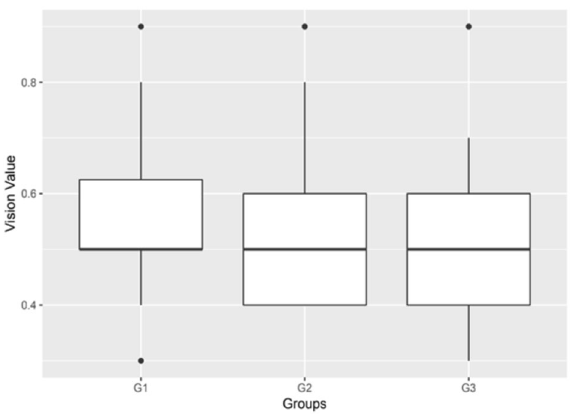
Figure 4. Box plots showing median levels of the BCVA in three groups of patients.